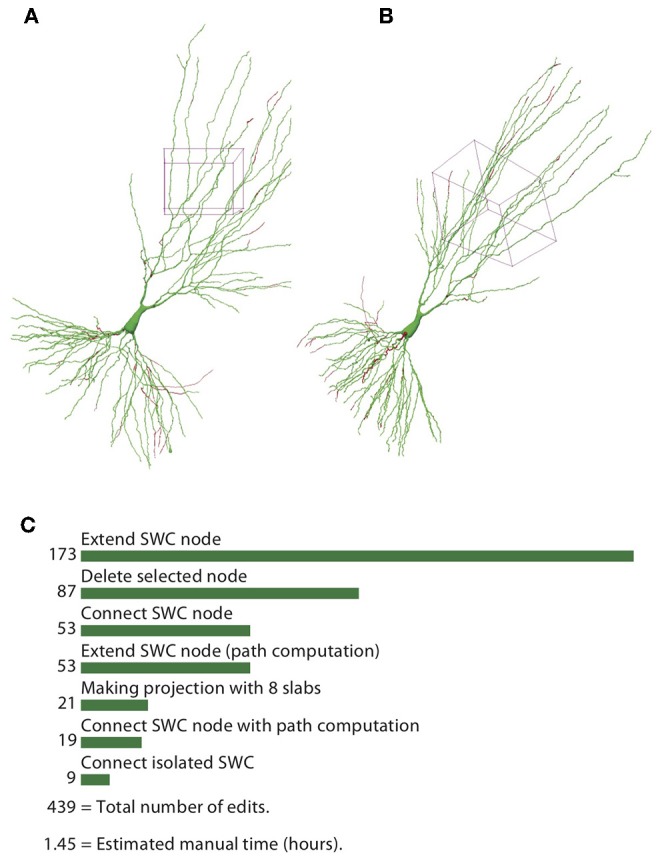
Reconstructed neuron after editing. (A,B) Two different views of the reconstructed neurons. The SWC points from the automatic reconstruction are in green, and those added in the editing process are in red. (C) Top operations done in the editing process and the total number of edits.